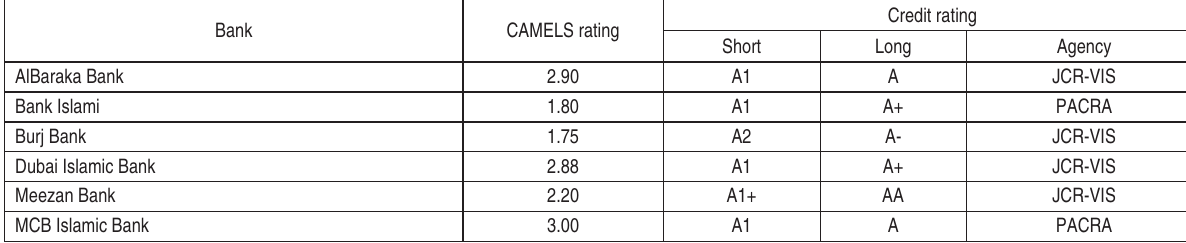
Table 6. Analysis of CAMELS and credit